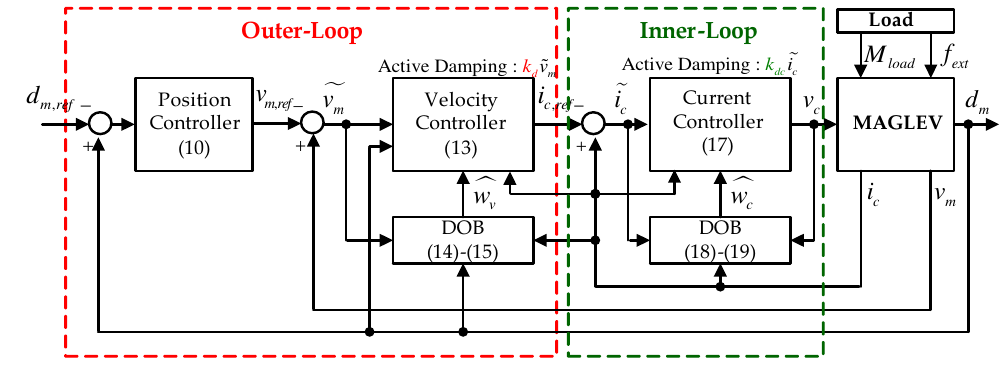
Figure 2. Control system